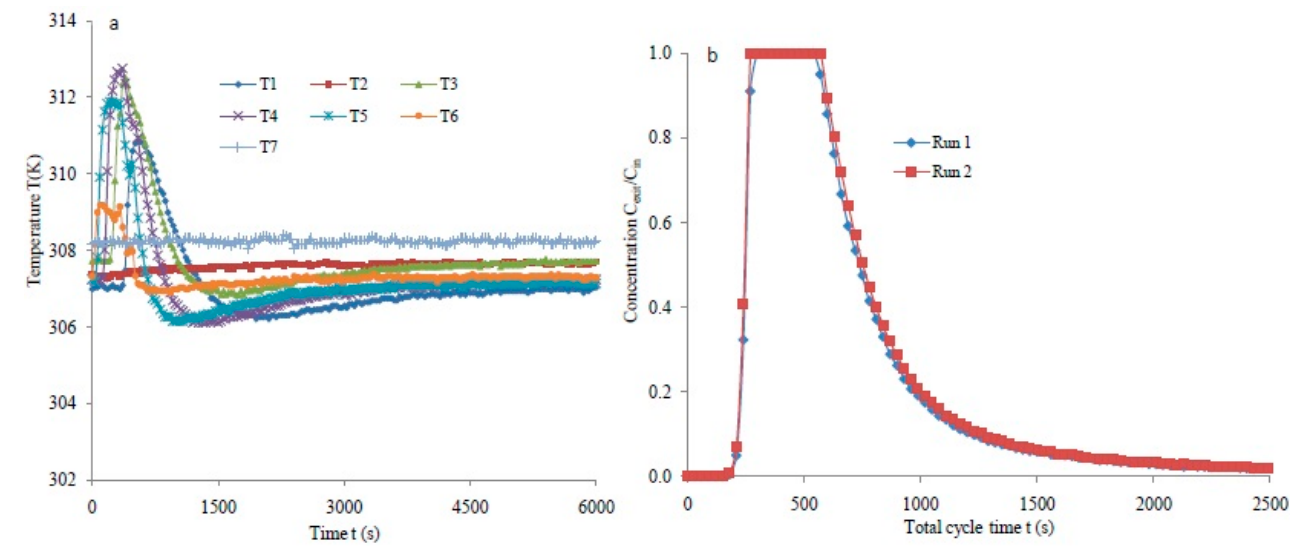
Figure 11. ( a ) Temperature curves for MS-3Å at F= 4 slpm and C in = 5%, and ( b ) repeatability assessment utilizing MS-3Å at F = 4 slpm, C in =5% and T = 328 K.